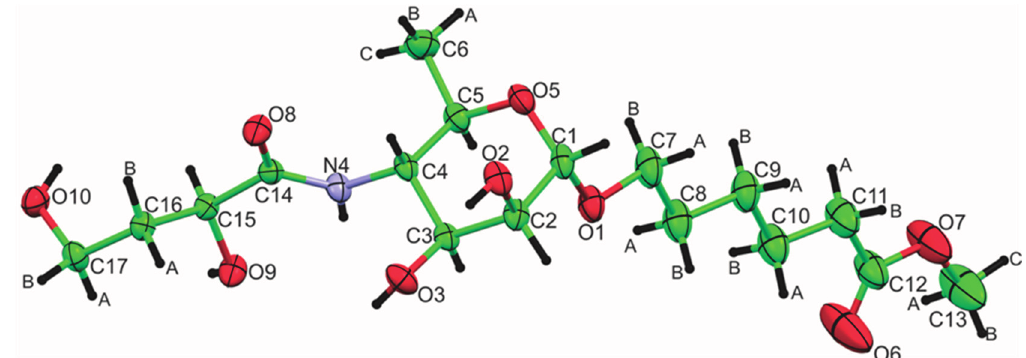
Figure 1. Thermal ellipsoid plot of 3 , at 50% probability for oxygen, nitrogen and carbon atoms. The number of the atoms is